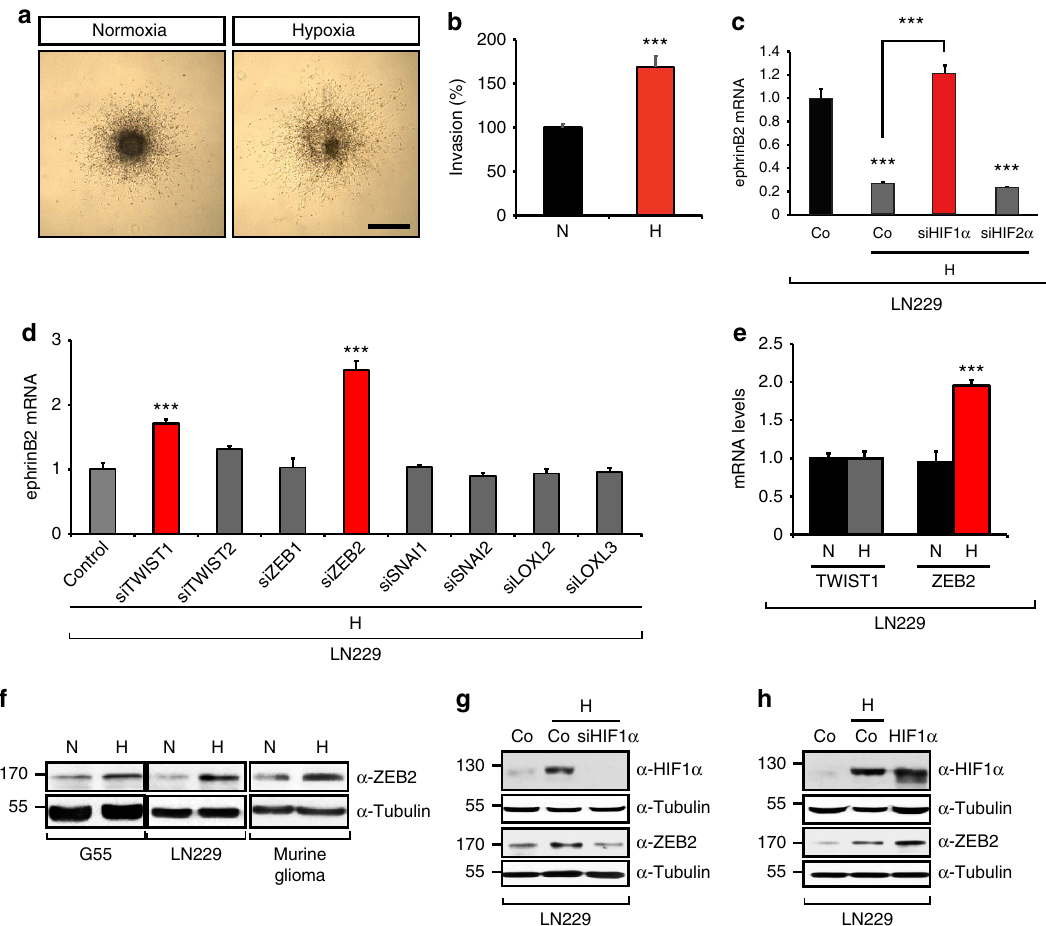
Figure 3 | Hypoxia and HIF-1 a downregulate ephrinB2. ( a , b ) Hypoxia induces glioblastoma invasion. Invasion of human G55 glioblastoma spheroids was quantified following incubation in a collagen gel at 21% O 2 (N) or 1% O 2 (H) for 48h ( n ¼ 7–11 spheroids). ( c ) Hypoxia downregulates ephrinB2 expression through HIF-1 a . qRT–PCR analysis of ephrinB2 mRNA levels in LN229 glioblastoma cells expressing scrambled control, HIF-1 a or HIF-2 a shRNA following exposure to 1% O 2 (H) for 18h ( n ¼ 3). ( d ) ZEB2 mediates the HIF-1 a -induced downregulation of ephrinB2. siRNA-based screen of transcriptional EMT repressors in LN229 glioblastoma cells following exposure to 1% O 2 (H) for 18h ( n ¼ 3); the red line marks hypoxic ephrinB2 expression